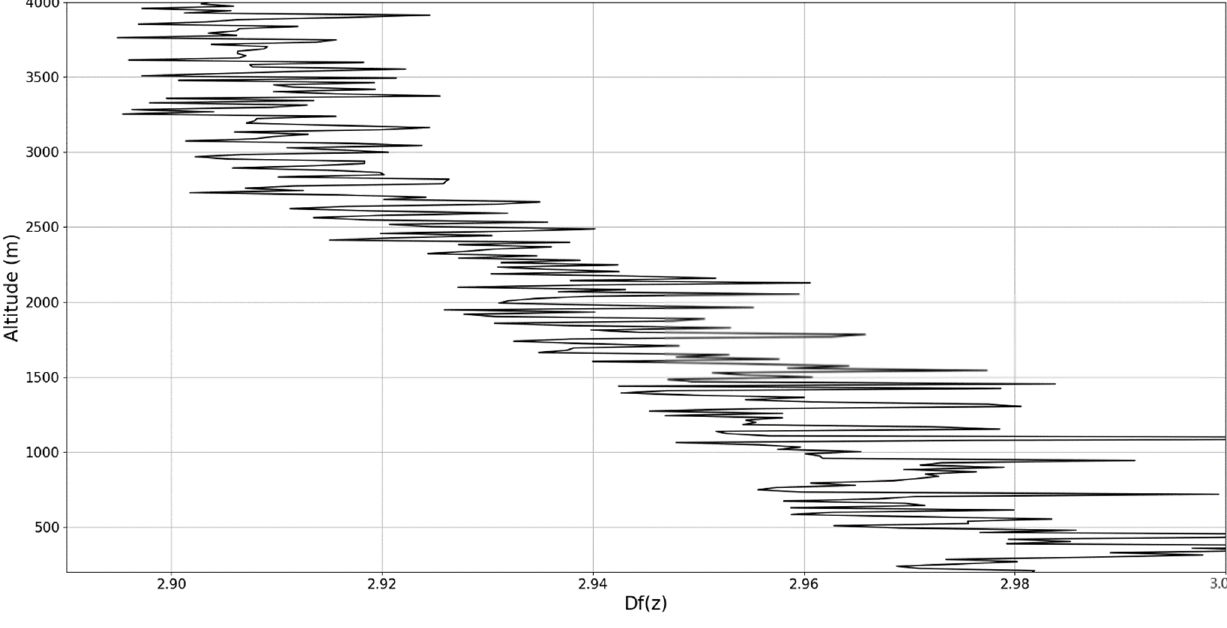
λ = 1064 nm, Galat F profile,